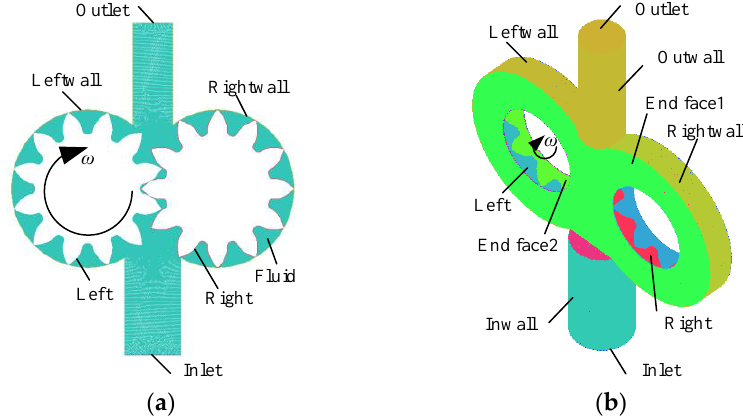
Figure 4. Mesh generation of gear pump simulation model: ( a ) 2D initial model; ( b ) 3D initial model.